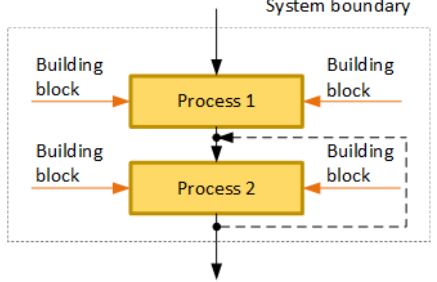
Figure 4. The functional diagram.